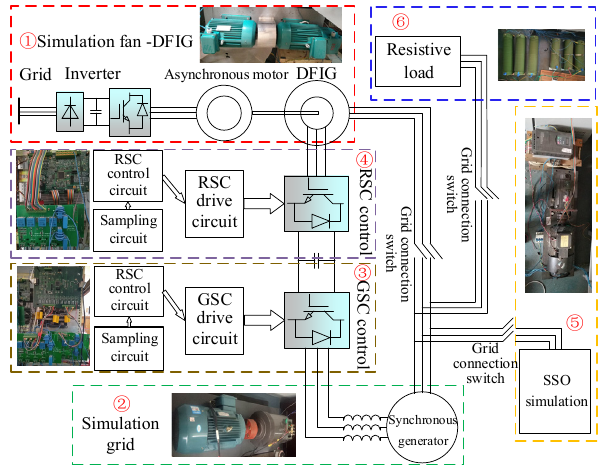
Figure 13. Layout diagram of experimental platform for a DFIG system.